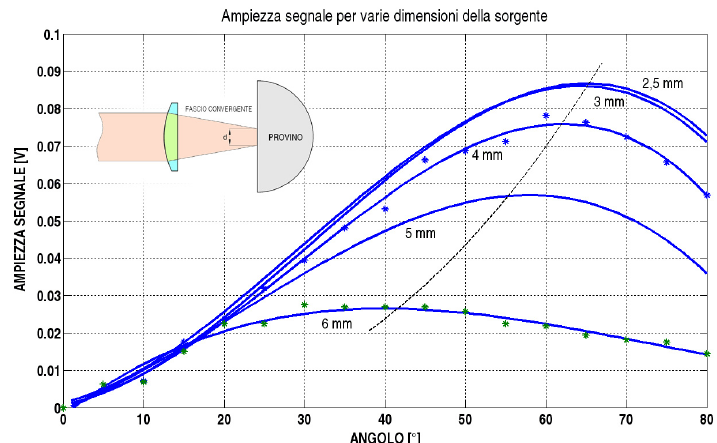
Figura 4: Ampiezza del segnale relativo all’onda longitudinale al variare dell’angolo di ricezione per diversi diametri dell’area irradiata e un'energia di 10 mJ. La curva tratteggiata interpola i massimi delle varie